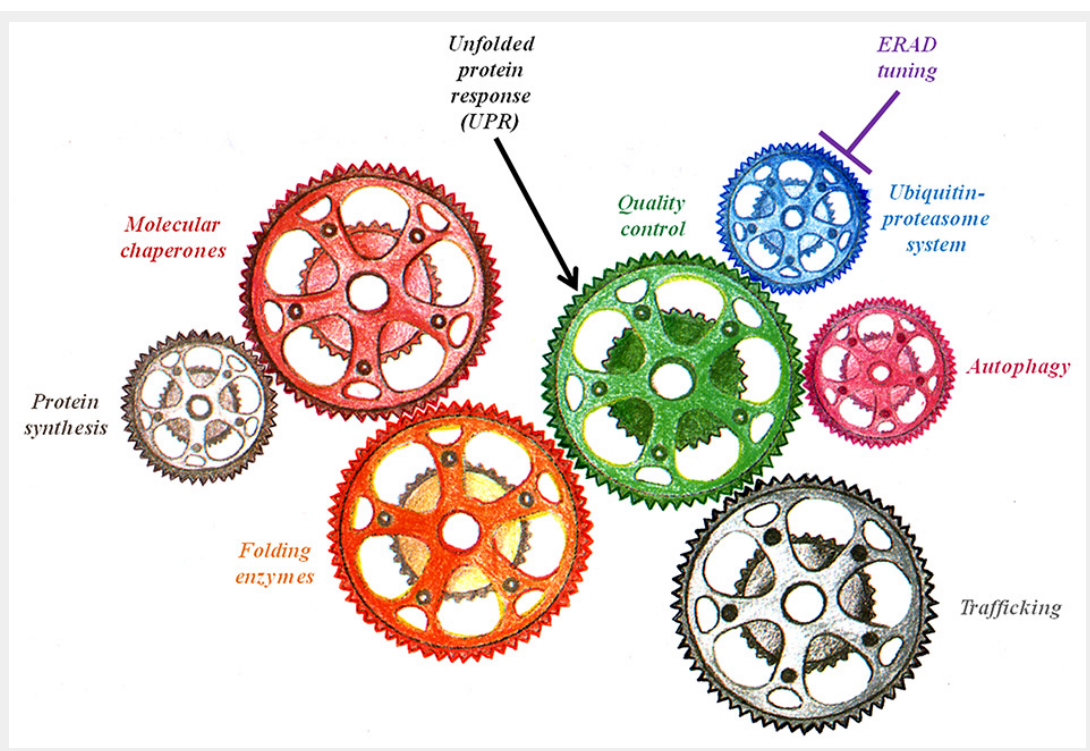
Figure 4 Schematic of the proteostasis network. The main components that regulate and maintain protein homeostasis (proteostasis) are illustrated as gears of a